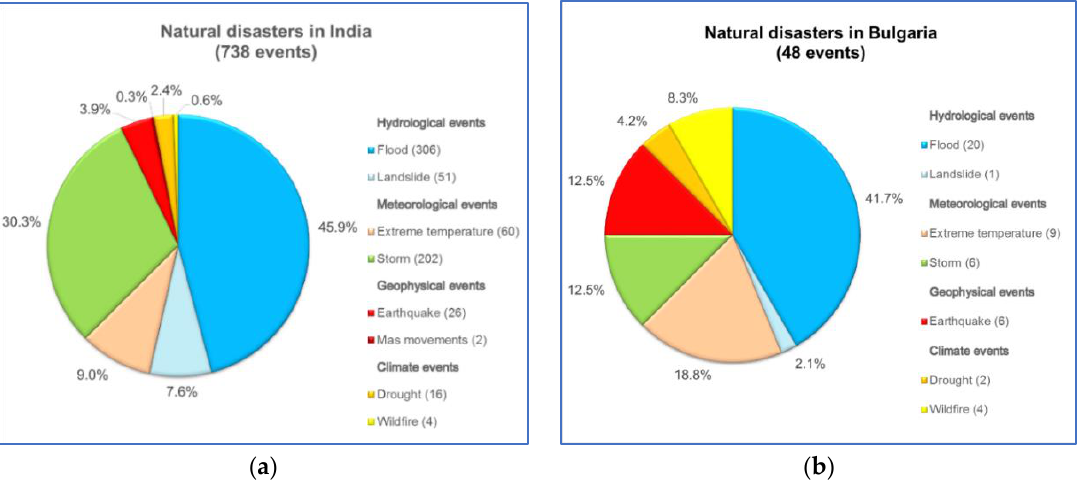
Figure 2. Comparison between the number of disasters in India ( a ) and Bulgaria ( b ) for the period 1900–2020 according to data from EM-DAT [60] (the number of relevant events is given in brackets) (accessed on 29 January 2021).